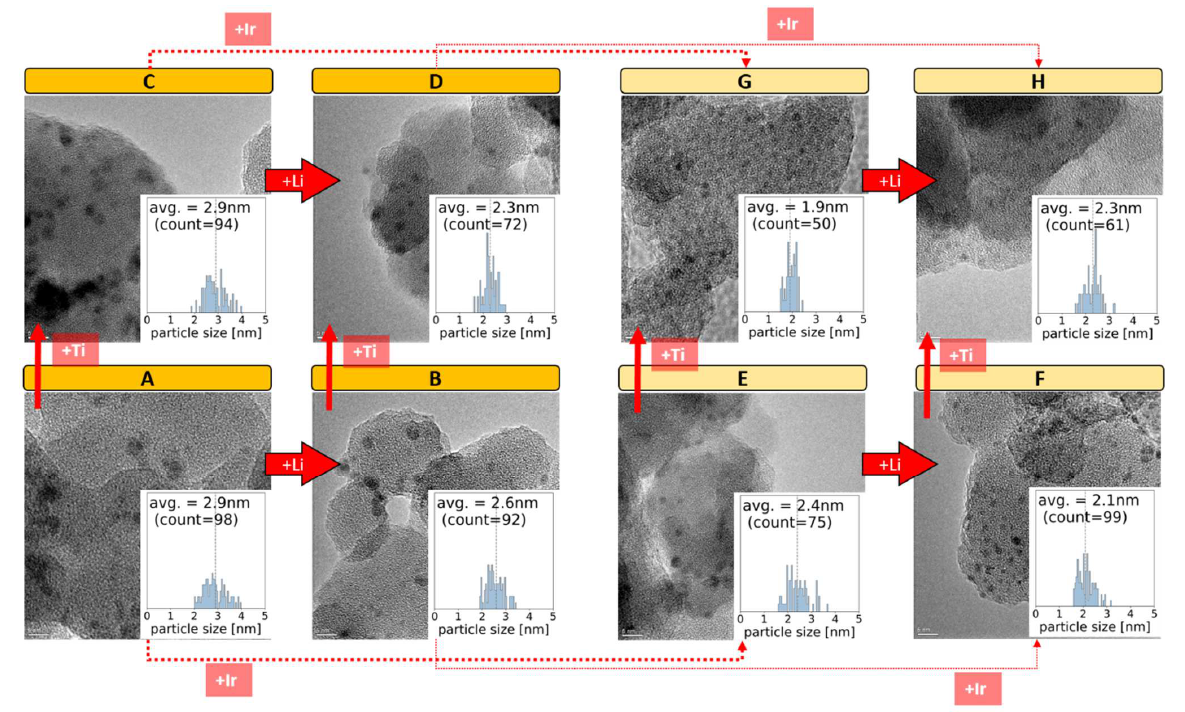
Figure 1. Overview of TEM images of fresh catalysts at 250 kx magnification. The header above each image ( A – H ) represents the respective catalyst depicted in Scheme 1. Compositional differences be- tween catalysts are demonstrated via arrows, such that each arrow shows the resulting compositional change in the catalyst towards which it is pointing. The average Rh particle diameter size is also depicted for each catalyst. The y-axis of the histograms depicts the normalized frequency.